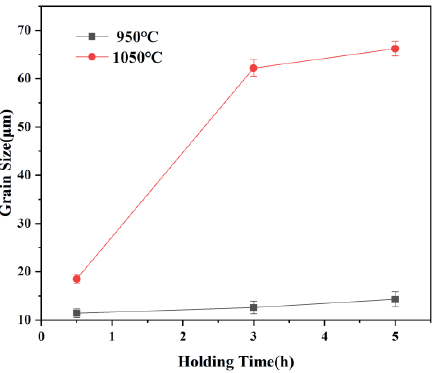
Figure 3. Experimental data for austenite grain coarsening against holding time at 950 °C and 1050 °C.